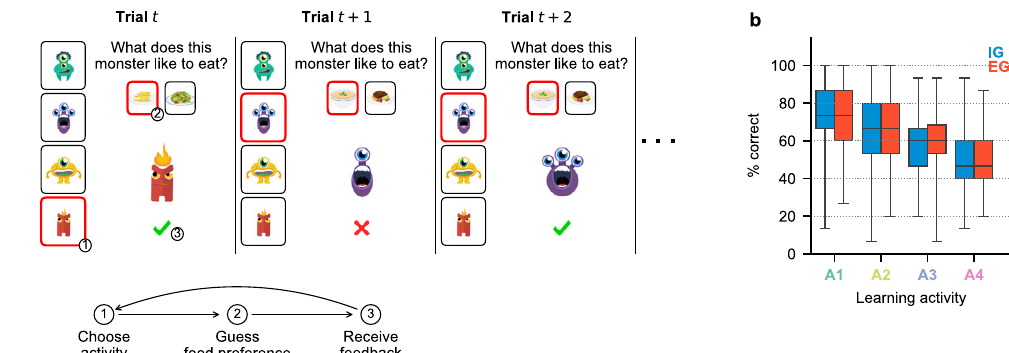
Fig. 1 Task design and dif fi culty manipulation. a Trial structure during free play. The panels show 3 example free-choice trials consisting of 3 steps each. Each trial began with a choice among 4 "monster families" depicted as visual icons (1). This was followed by the presentation of a randomly drawn individual from that family and a prompt to guess which of two possible foods the individual liked to eat (2). After guessing (2), the participant received immediate feedback (3) and the next trial began. Participants were free to repeat the previously sampled activity (e.g., trial t + 2 in this fi gure) or switch to any other monster family (e.g., trial t + 1) as they wished. b Performance during the forced-choice familiarization stage. Each box plot shows the %correct (PC) during the 15 familiarization trials in which participants had to play each activity for the IG (blue; N = 186) and EG (red; N = 196) groups. Horizontal bars inside boxes show the median values across all participants in a group; box boundaries show the 1st and the 3rd quartiles; whiskers show sample minima and maxima. Image credits ( a ): monster character designs by macrovector/Freepik; food-item designs by brgfx/Freepik. Source data for b are provided as a Source Data fi